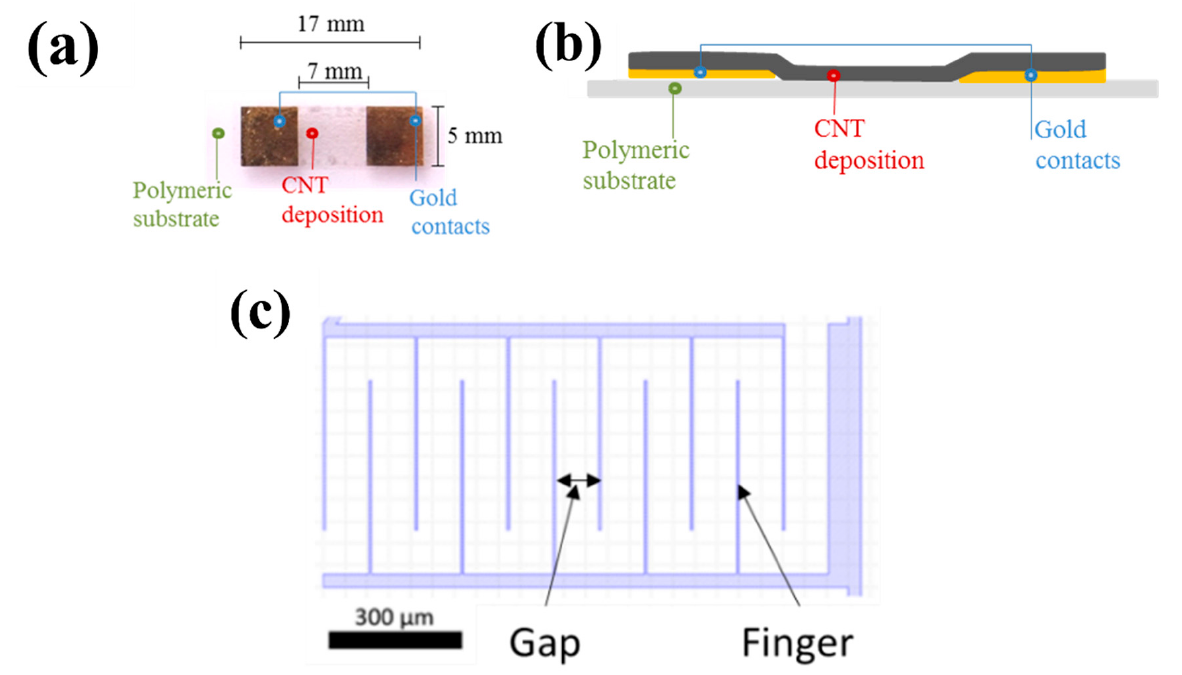
Figure 3. ( a ) Top view and ( b ) cross section of an example of two terminal resistive CNT sensors on ETFE (Ethylene Tetra Fluoro Ethylene). Reproduced from [92]. ( c ) Schematic of interdigitated electrodes.